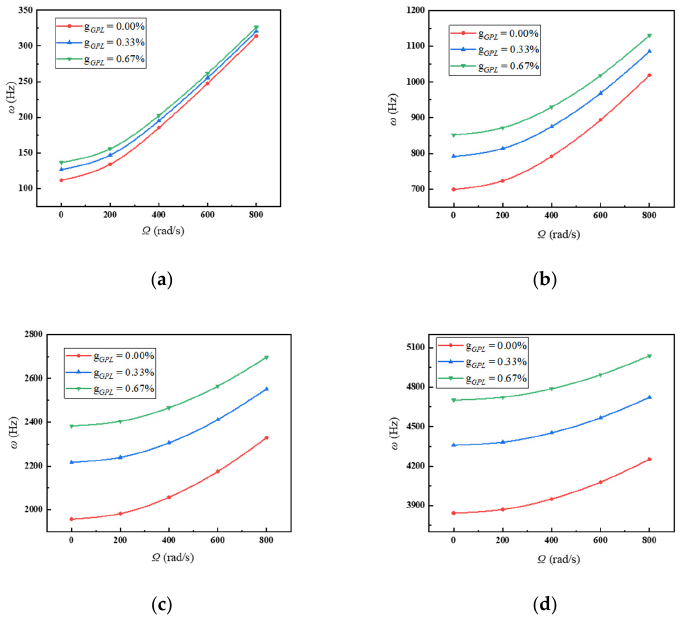
Figure 6. Variations of frequencies with rotating speed under different GPL weight fractions. ( a ) First frequency; ( b ) second frequency; ( c ) third frequency; ( d ) fourth